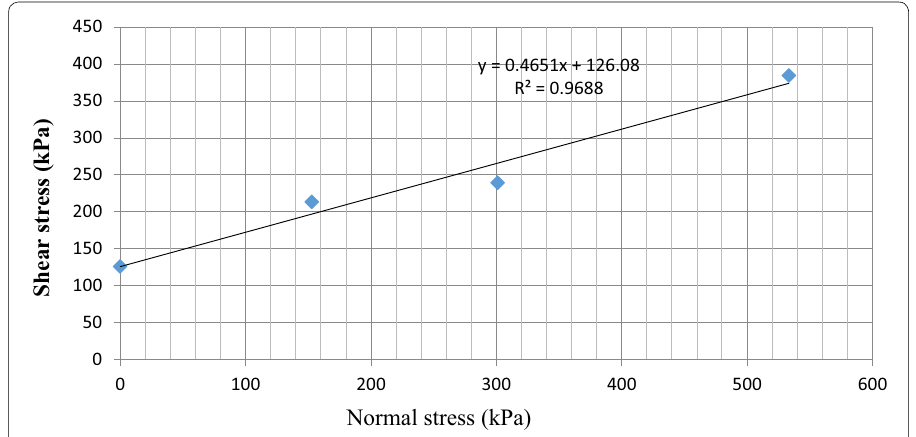
Fig. 9 Shear versus normal stress plot using peak normal stress approach for soil concrete interface for sample